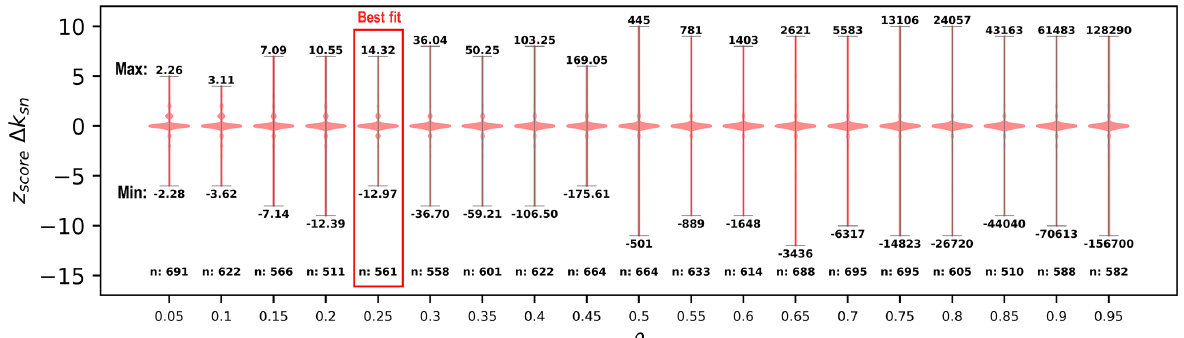
Figure 9. Sensitivity of the knickpoint extraction to the concavity index ( θ ). As different values of θ result in different values of k sn , we use a normalised z score (i.e. the difference to the mean normalised by the standard deviation) to compare the overall spread of (cid:49)k sn . The plot shows probability distributions of the z score of (cid:49)k sn represented by violin plots calculated with a kernel density estimation (bandwidth 0.20). The outliers and their relative magnitudes are affected by this parameter, whereas the general data distribution remains similar. The “min” and “max” stated above and below the violin plots respectively represents the minimum and maximum (cid:49)M χ for each run.